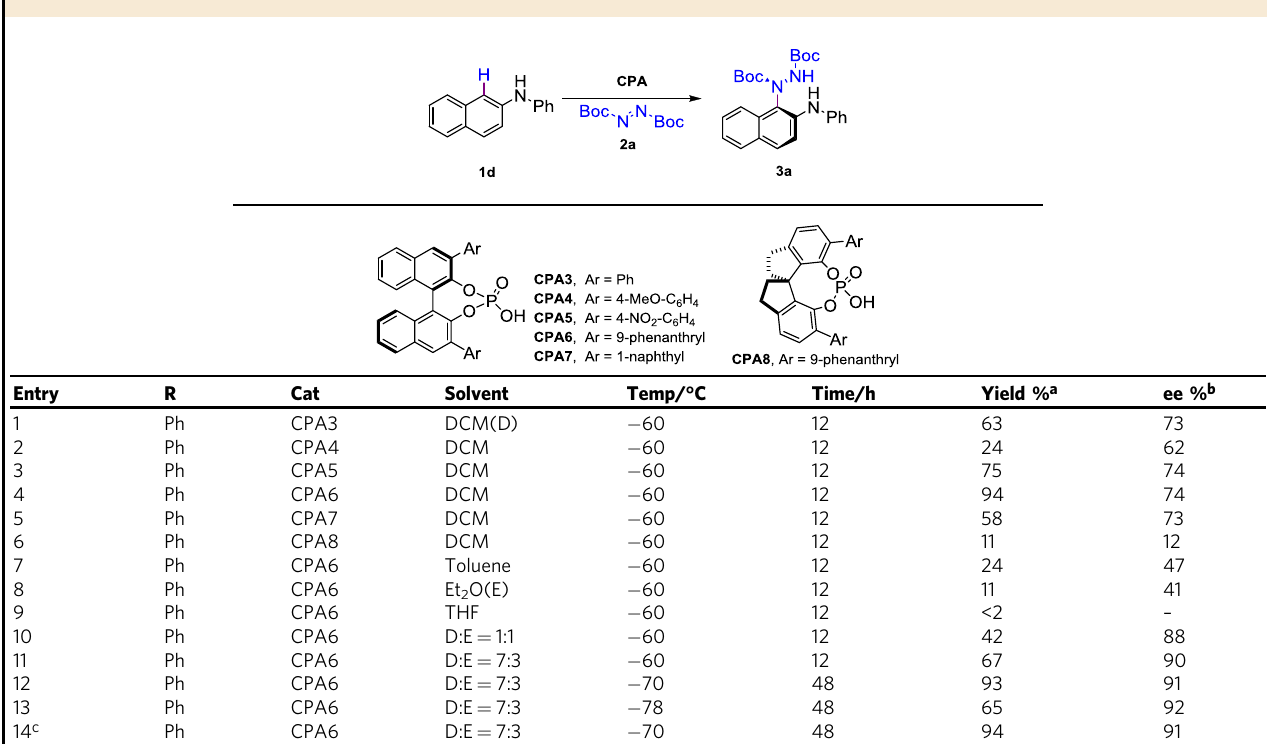
Table 2 Optimization of reaction